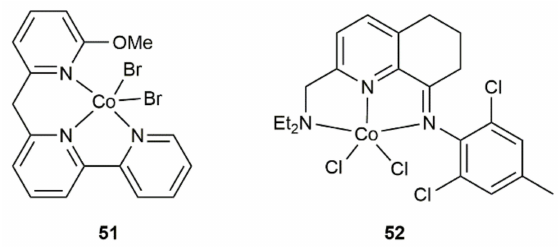
Figure 8. Structure of the cobalt(II) complexes 51 and 52